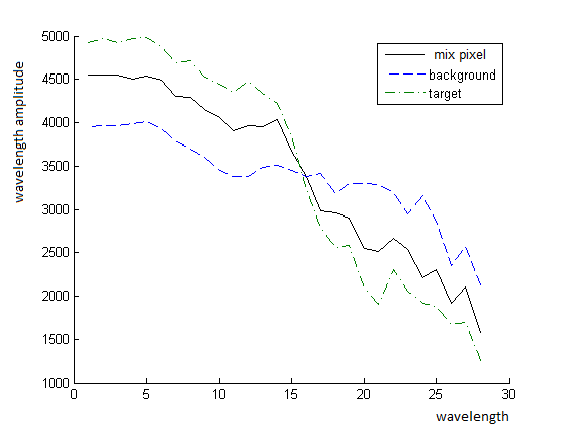
Figure 3. Spectra of the background, the mixed pixel and the target from Figures 1 and